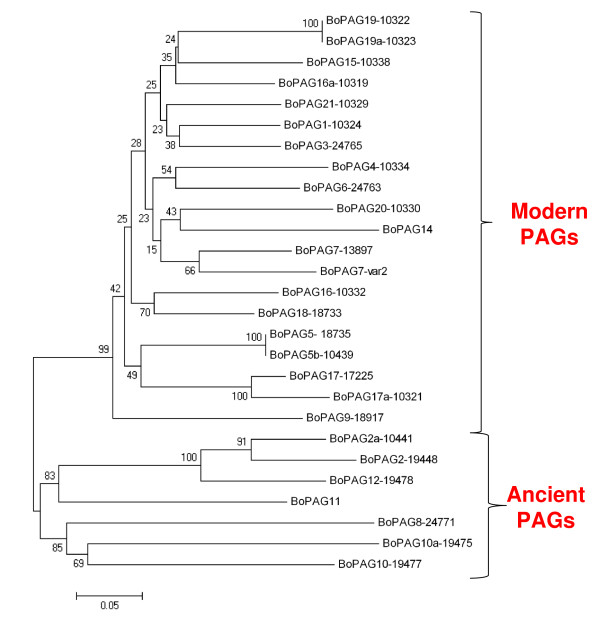
Evolutionary relationships among the bovine PAG genes represented in the bovine genome build 3.1. The tree was created from the inferred amino acid sequences by using the Minimal evolution method in the MEGA 4.0 program. The tree was drawn to scale, and the percentage representations obtained from the bootstrap analysis were shown next to the appropriate branch point. Notice the clear separation of the PAG gene family into two groups, the modern and the ancient PAGs. Also notice the relatively shorter branch lengths in the modern PAG clusters compared to the ancient PAGs.